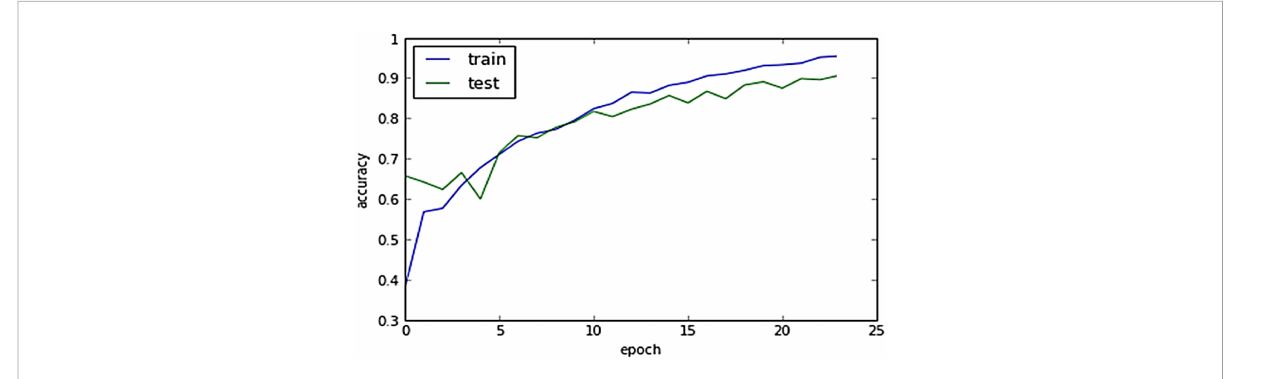
FIGURE 5 Performance evaluation of the proposed model using varying epoch size.